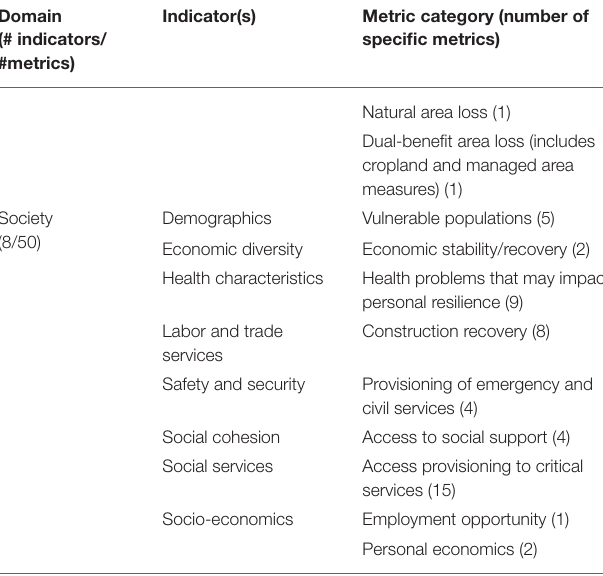
TABLE 1 | List of CRSI domains, indicators, scope, and number of metrics. Domain (#